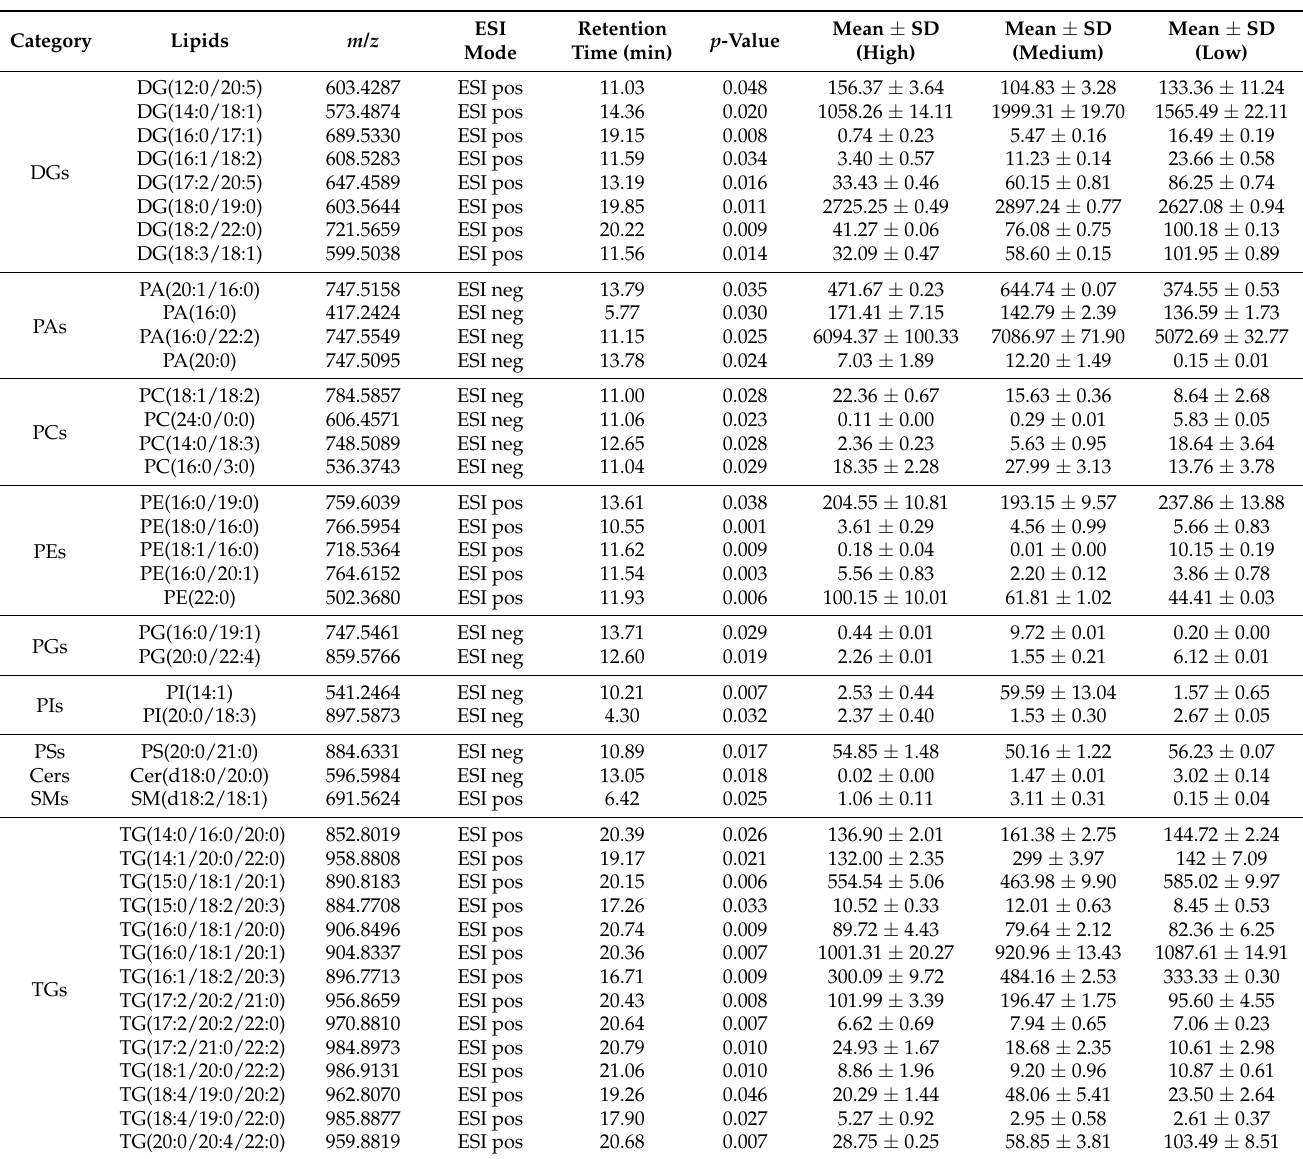
Table 2. Annotations and contents ( µ g/kg) of significantly different lipids in three sensory grades (high, medium and low) of indica